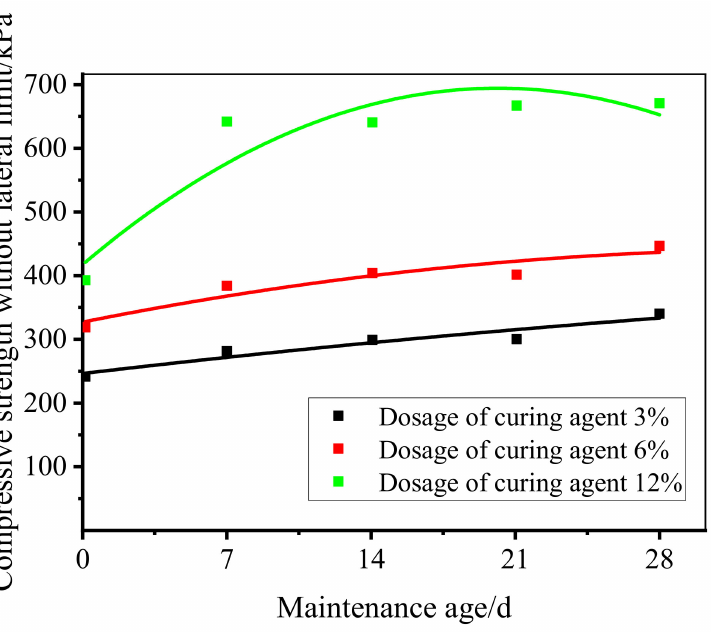
Figure 5. Relationship between unconfined compressive strength of soil samples at different